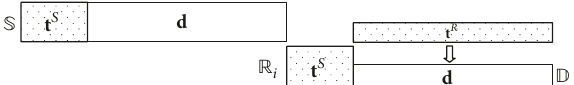
Figure 1. The individual channel impulse response links are = [ℎ (0), ℎ (1), . . . , ℎ (퐿 −1)] 푇 , h = defined as h 푆푅 푆푅 𝑖 푆푅 𝑖 푆푅 𝑖 푆푅 𝑖 푅 𝑖 퐷 𝑖 (0), ℎ (1), . . . , ℎ (퐿 − 1)] 푇 , 푖 = 1, 2 . Individual [ℎ 푅 𝑖 퐷 푅 𝑖 퐷 푅 𝑖 퐷 푅 𝑖 퐷 channel taps are independent and Rayleigh-distributed as ℎ (푙) ∼ CN (0, 휎 2 ) , ℎ (푙) ∼ CN (0, 휎 2 ) . The 푆푅 𝑖 푅 𝑖 퐷 푆푅 𝑖 ,푙 푅 𝑖 퐷,푙